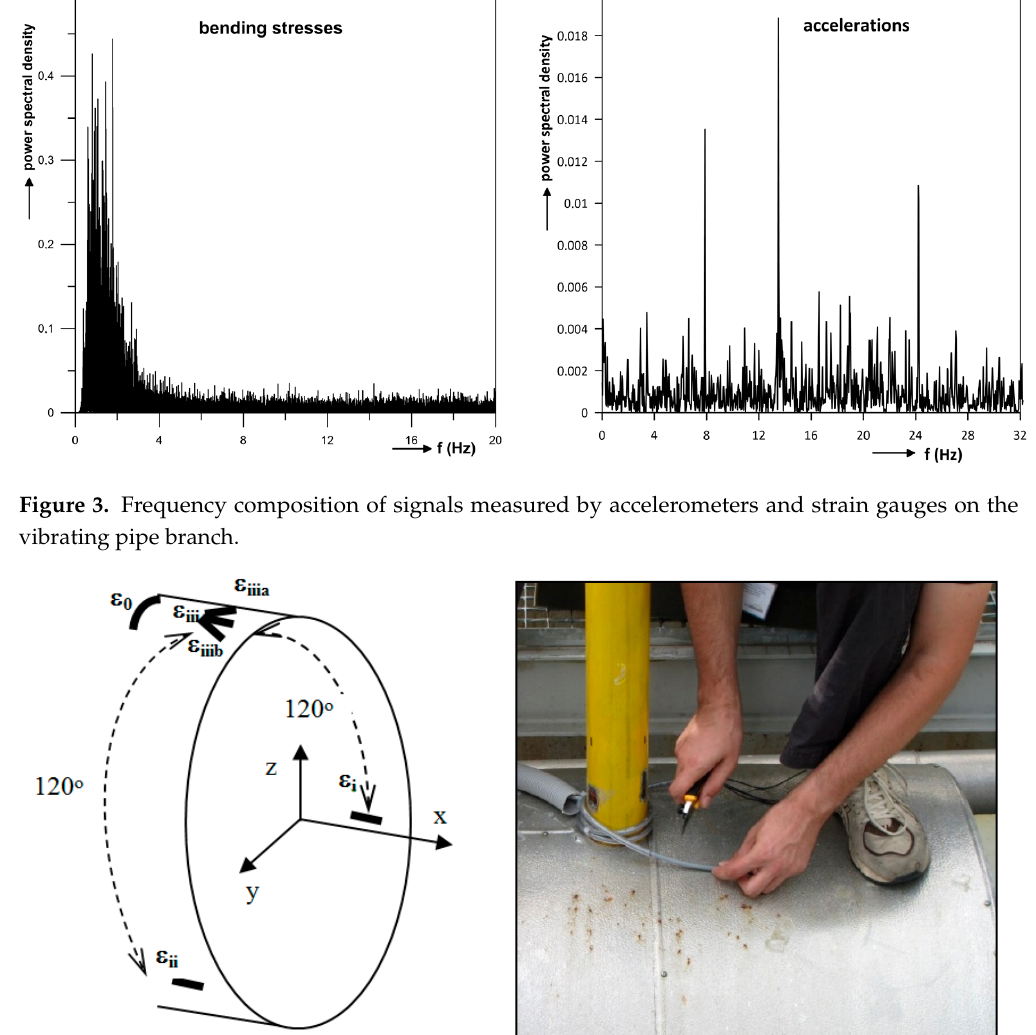
Figure 4. ( a ) The arrangement of strain sensors along the perimeter of the pipeline, and ( b ) the application of the strain sensors (gauges) on the real pipe.